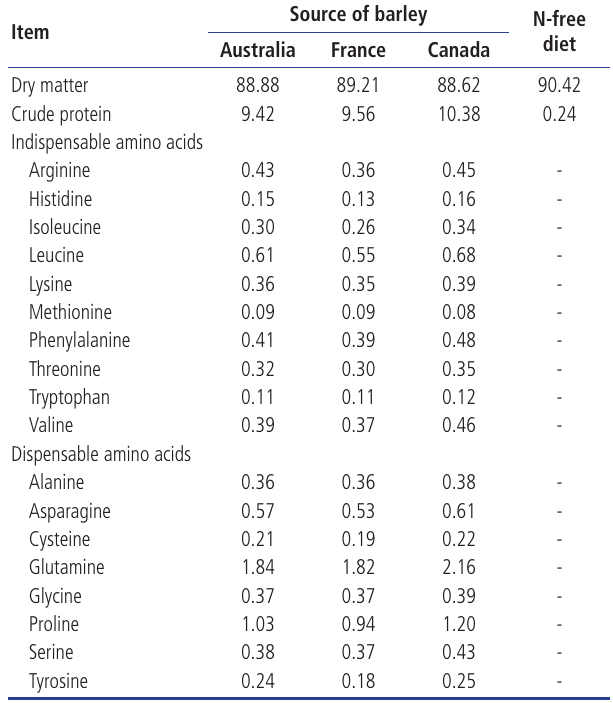
Table 3. Analyzed chemical composition of diets used in Exp. 1 (% as-fed basis) 1) Item